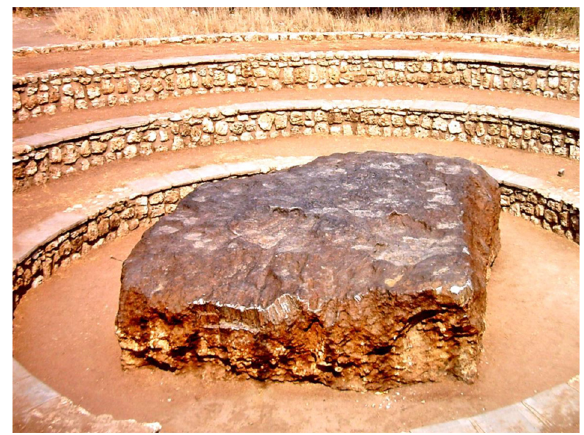
Figure 11. The Hoba ataxite iron meteorite, Grootfontein Nami- bia. Photograph taken by author,